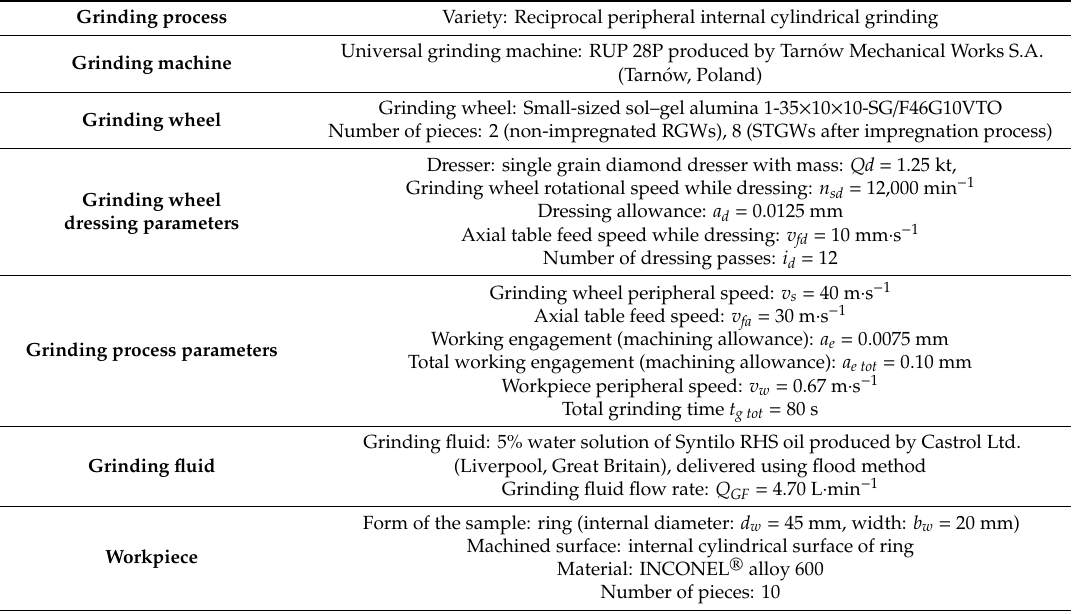
Table 5. Characteristics of grinding process